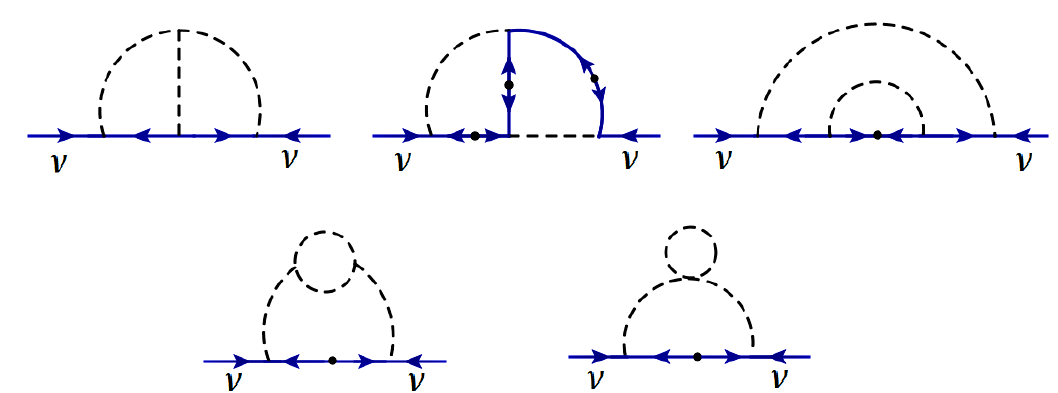
Figure 3 . Topologies of two-loop neutrino mass diagrams. Two Higgs bosons should be attached to internal lines in all possible